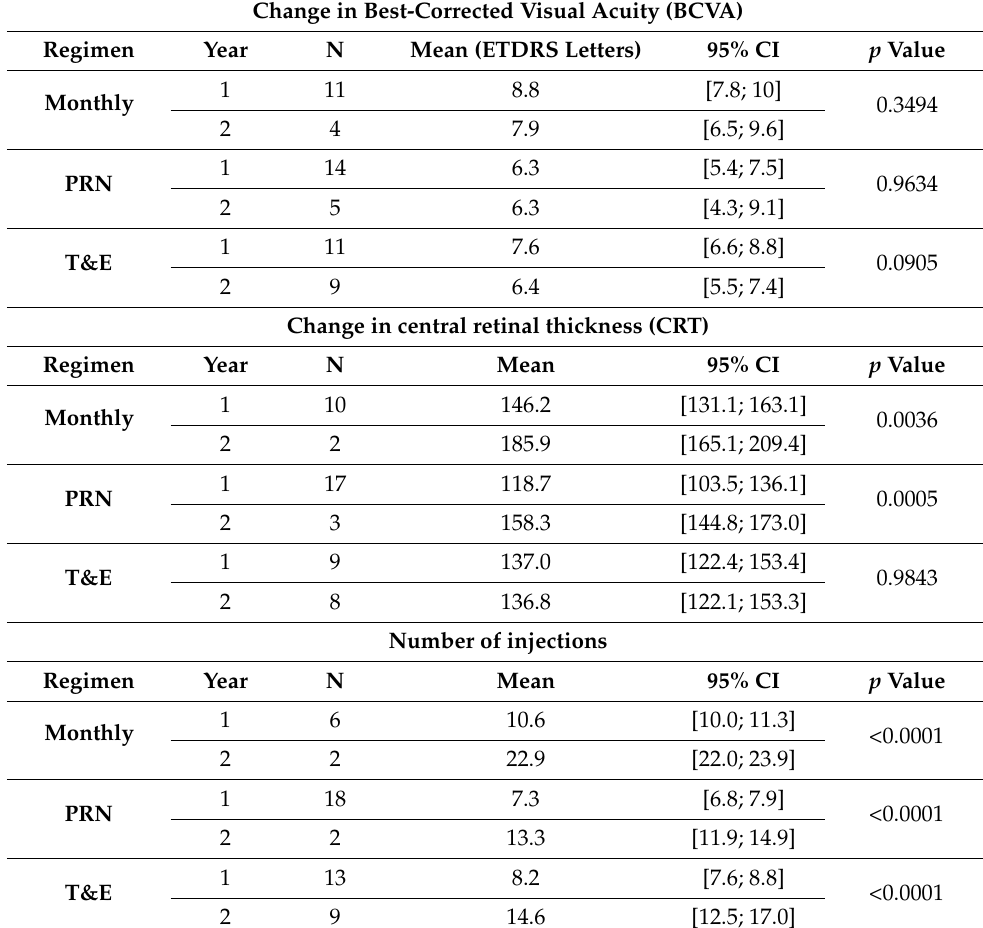
Table 3. Maintenance of changes in BCVA, CRT and IVI numbers over time using monthly, pro re nata and treat-and-extend